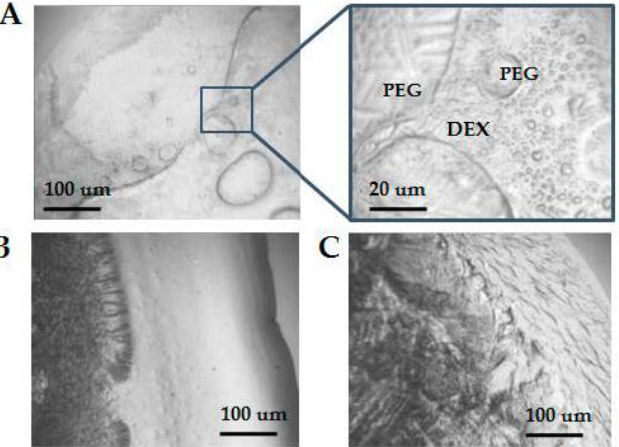
Figure 6. Area of dried drops of polymer mixtures and pure solutions visualized by light microscopy before Raman spectrometry. ( A ) Upper phase 2 UP2; ( B ) Dextran; ( C ) PEG.